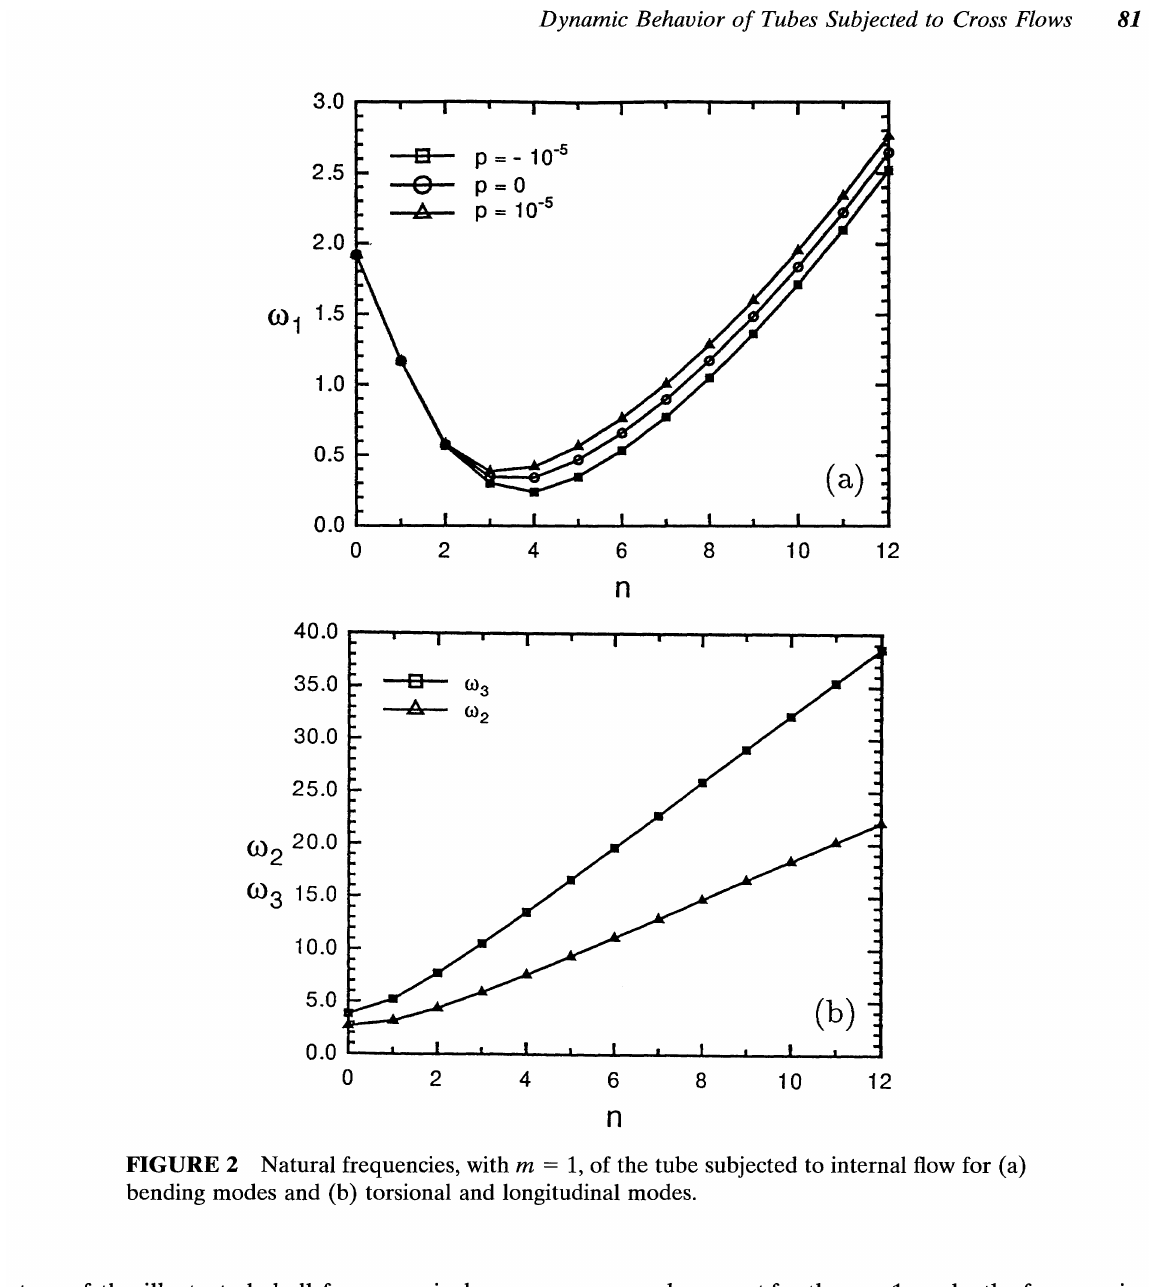
FIGURE 2 Natural frequencies, with m = 1, of the tube subjected to internal flow for (a) bending modes and (b) torsional and longitudinal